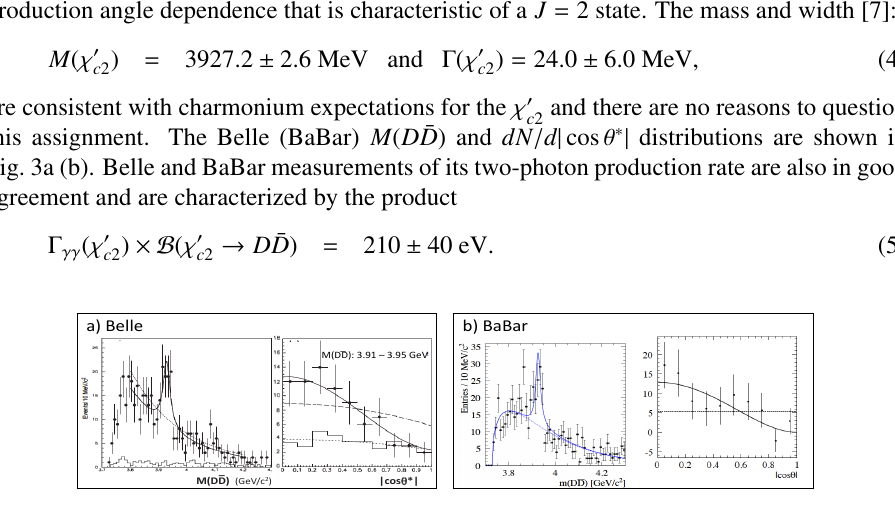
Figure 3. a) left : The M ( D ¯ D ) distribution for γγ → D ¯ D . The open histogram the D mass-sideband-determined background. The solid (dashed) curve shows results of a fit that includes (excludes) a χ (cid:48) for peak-region events with a solid (dashed) curve showing J = 2 ( J = 0) expectations. The histogram is the non-resonant contribution. (From ref. [13].) b) Corresponding plots from BaBar [14].